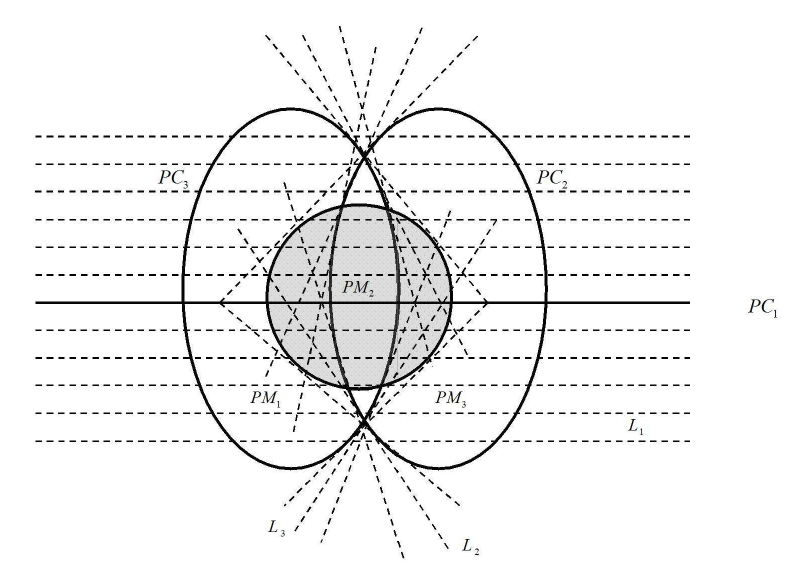
Figure 3. Detector plane with various filtering lines covering projection of ROI